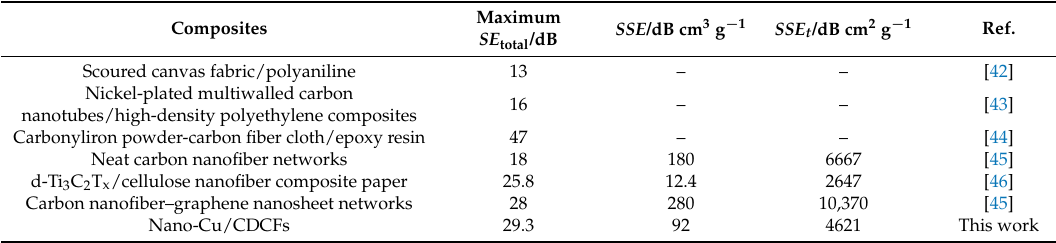
Figure 7. Graphical illustration of the EMI shielding mechanism of the core–shell structured nano-Cu/CDCFs composite. Table 1. Comparison of EMI shielding properties of composites.